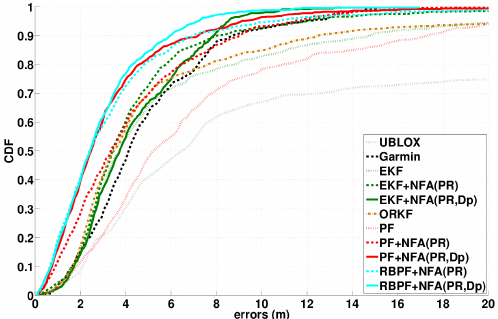
Figure 3. Cumulative distribution function of errors achieved by the four versions of KF, the five versions of particle filters and the two GPS solutions for our experiment of 11 min and 40 s.